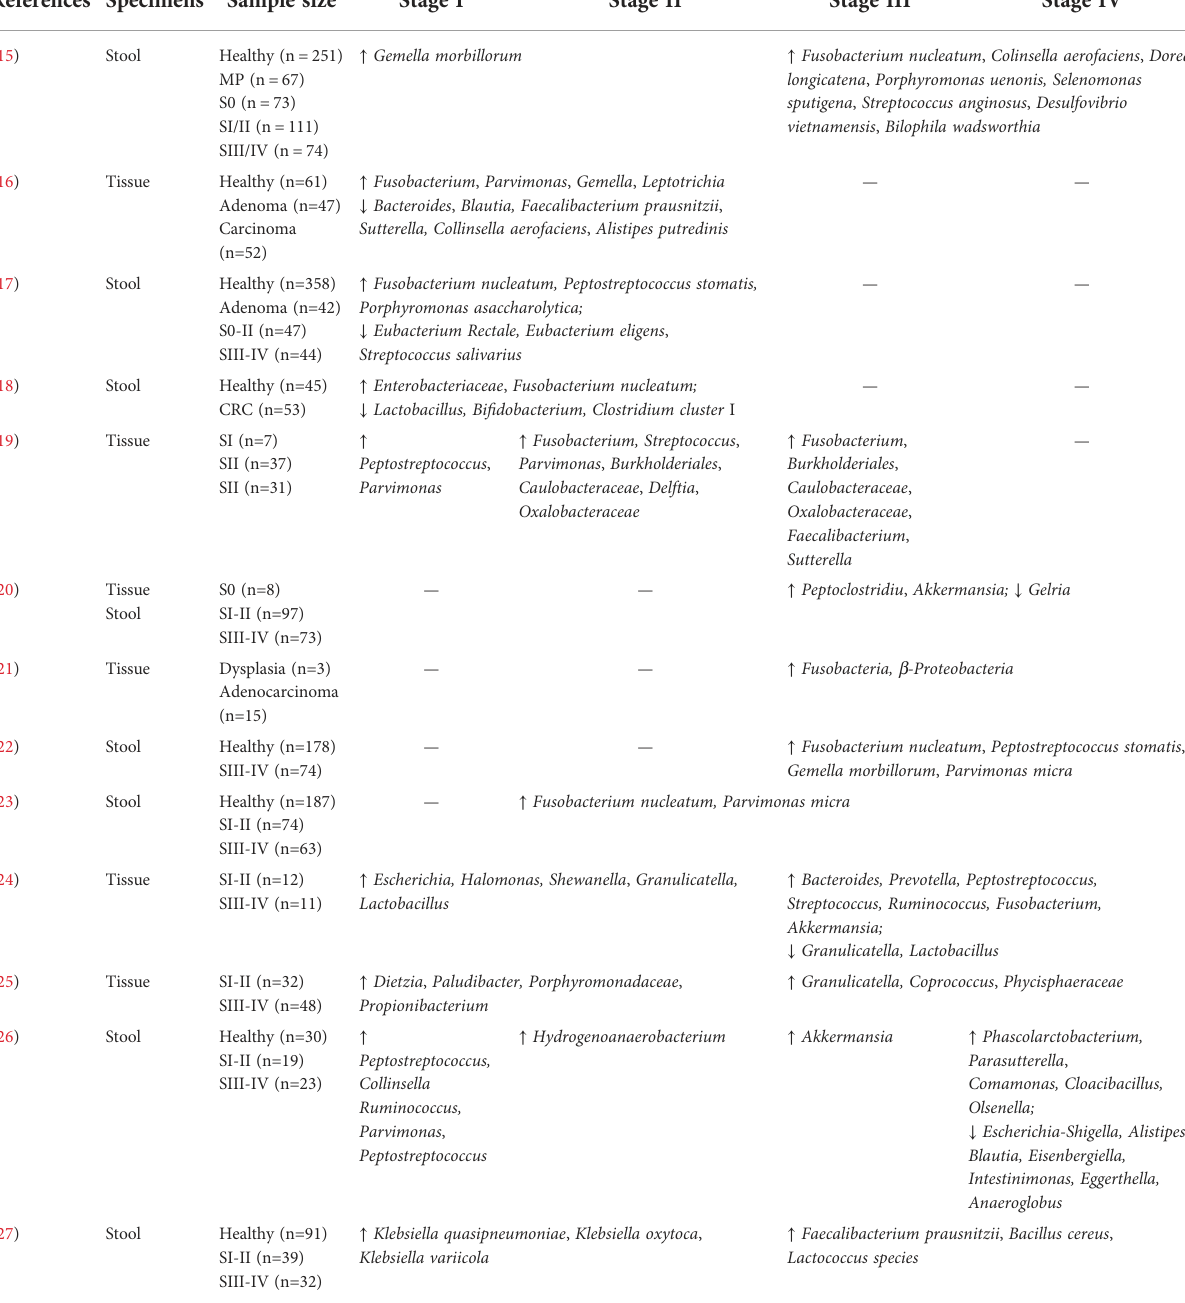
TABLE 1 Summary of microbial changes across stages of